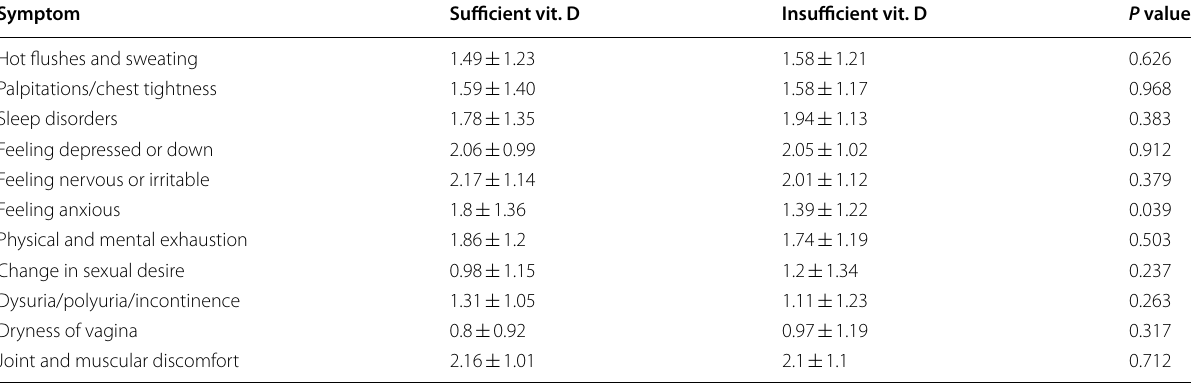
Table 3 Descriptive statistics of menopausal rating scale (MRS) among studied sample ( n